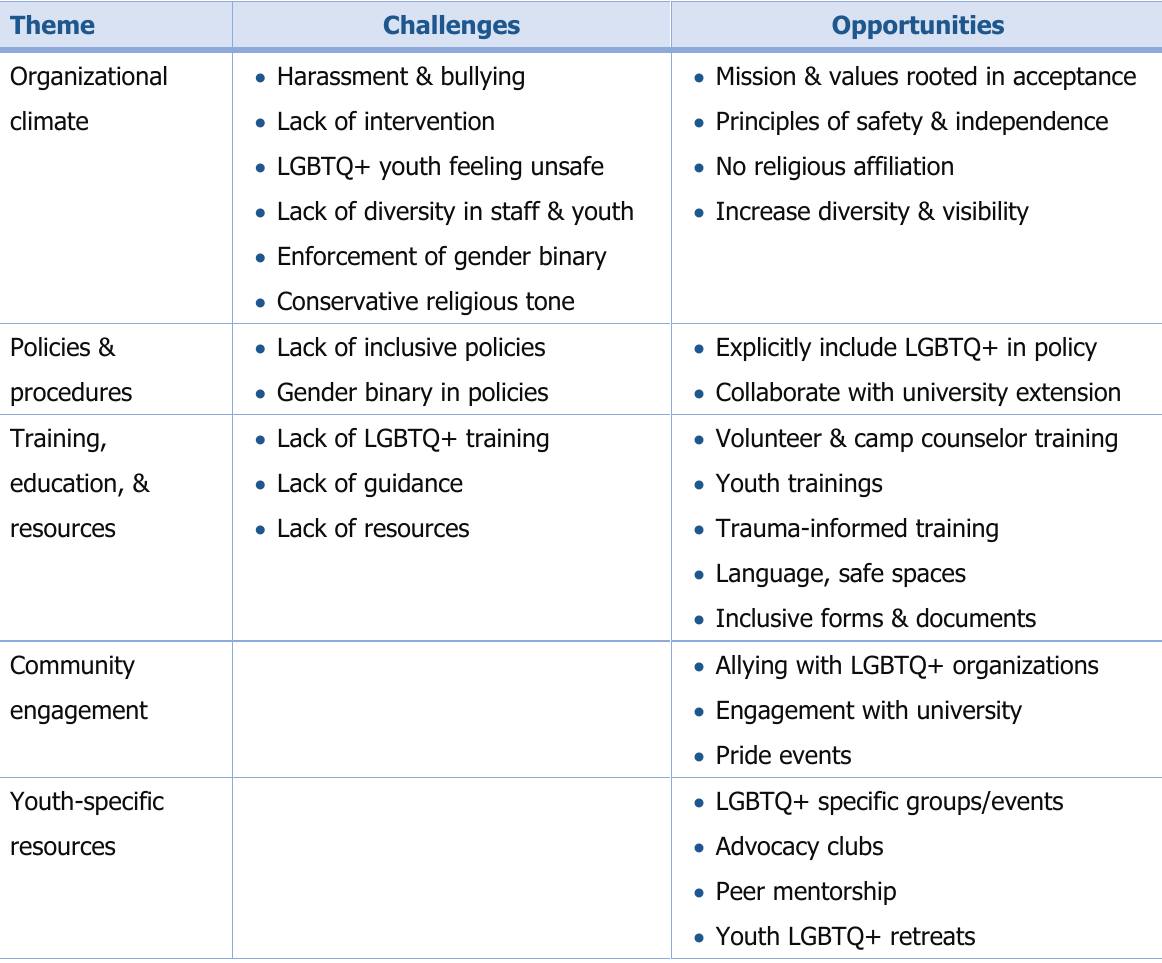
Table 2. Challenges and Opportunities for LGBTQ+ Inclusion in